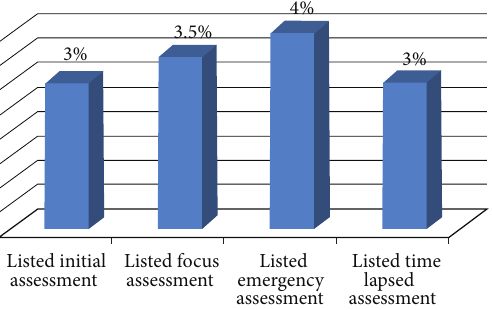
Figure 3: The frequency distribution of the respondents according to their knowledge status on nursing process in Mekelle Zone hospitals, northern Ethiopia, March